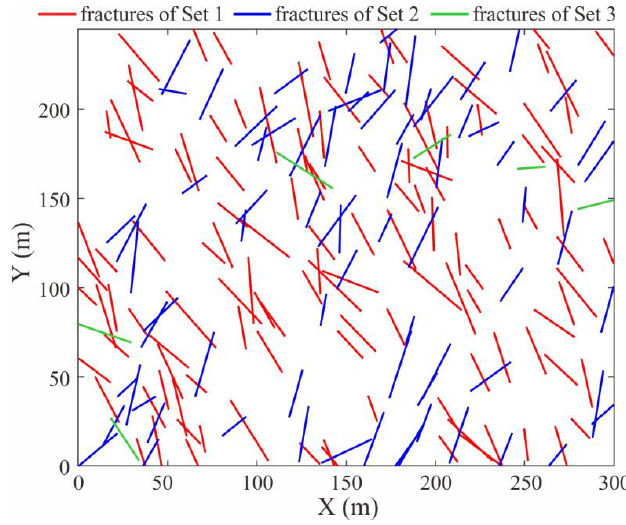
Figure 4. Geometric model of cracks in Xinli.